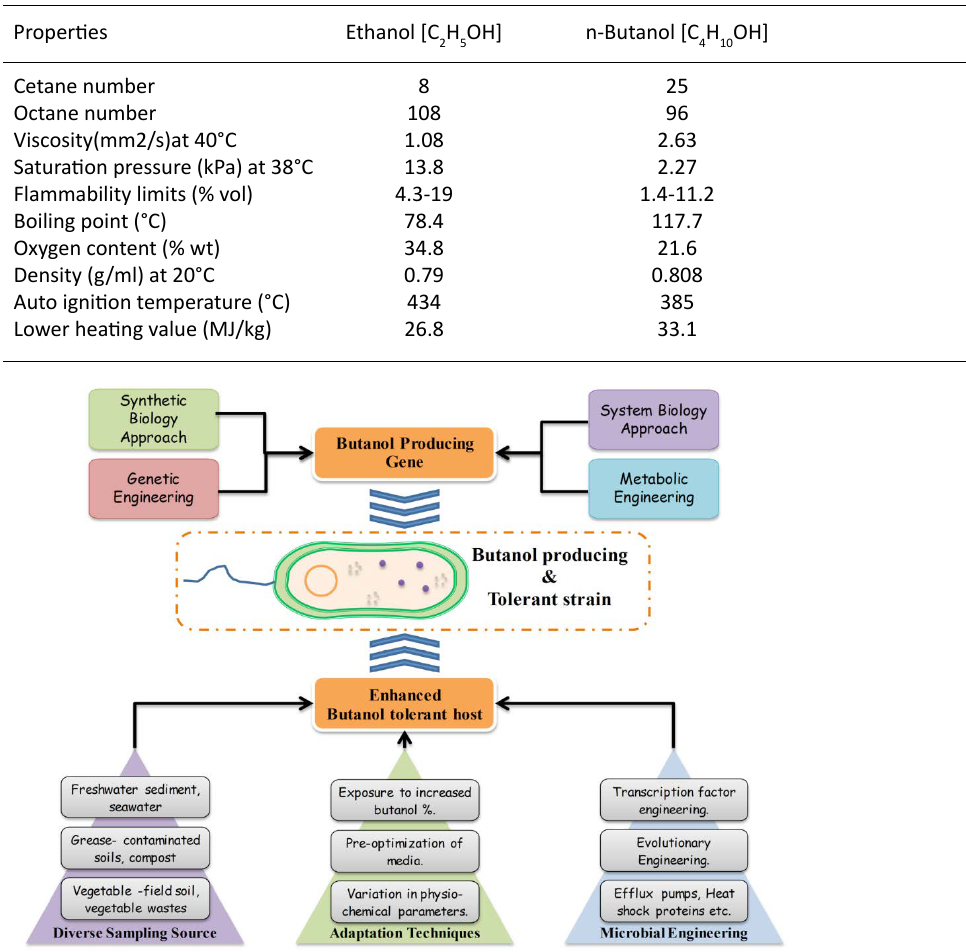
Fig. 3. Various approches for development of high Butonol producing and tolerant